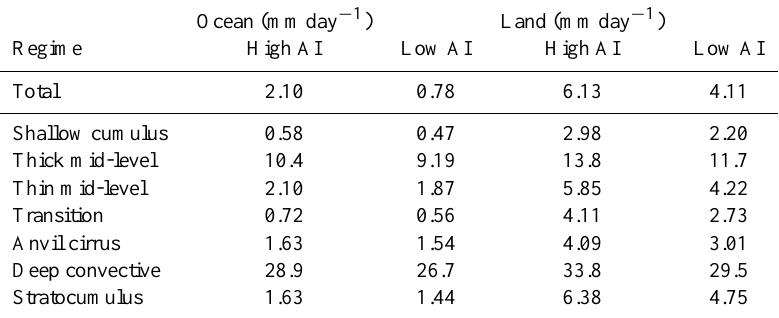
Table 2. The mean total TRMM 3B42 merged precipitation (mm) for the 6h following T + 0 for the years 2003–2007. These are the mean precipitation rates over the period T + 0 → + 6 for each of the sub-figures in Fig.